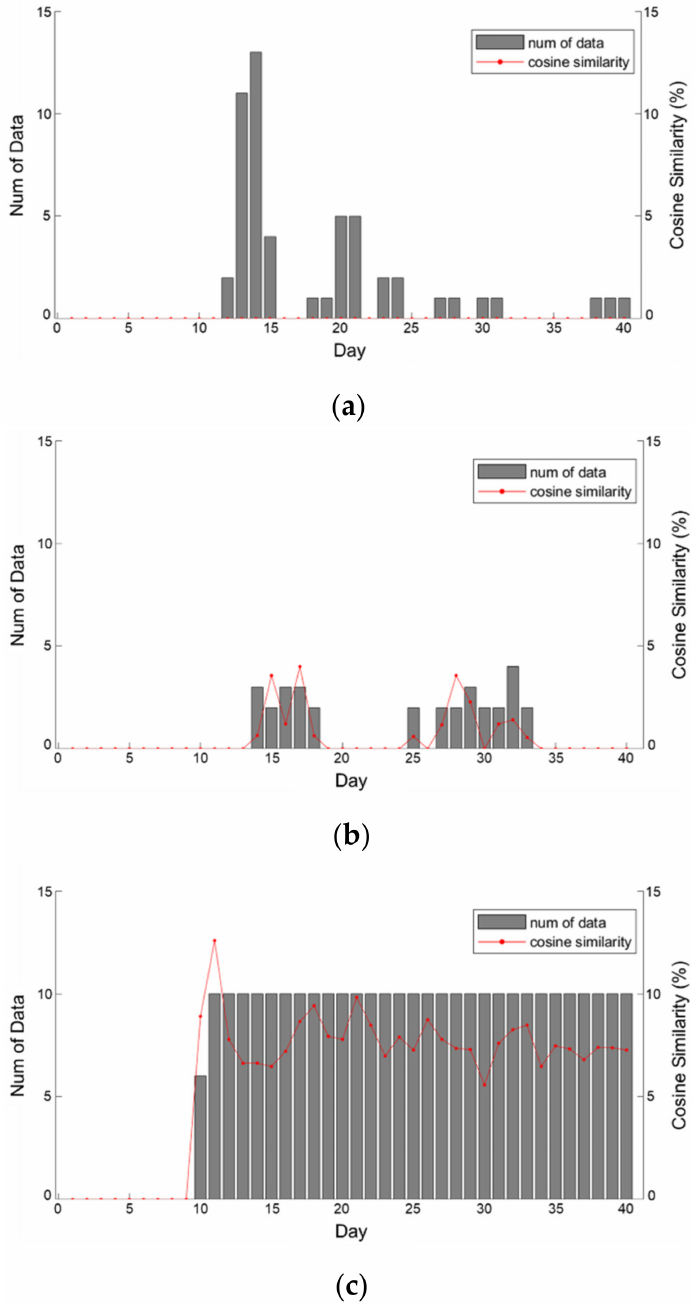
Figure 5. Analysis results of unstructured data. ( a ) Blogs; ( b ) Twitter; ( c ) a news